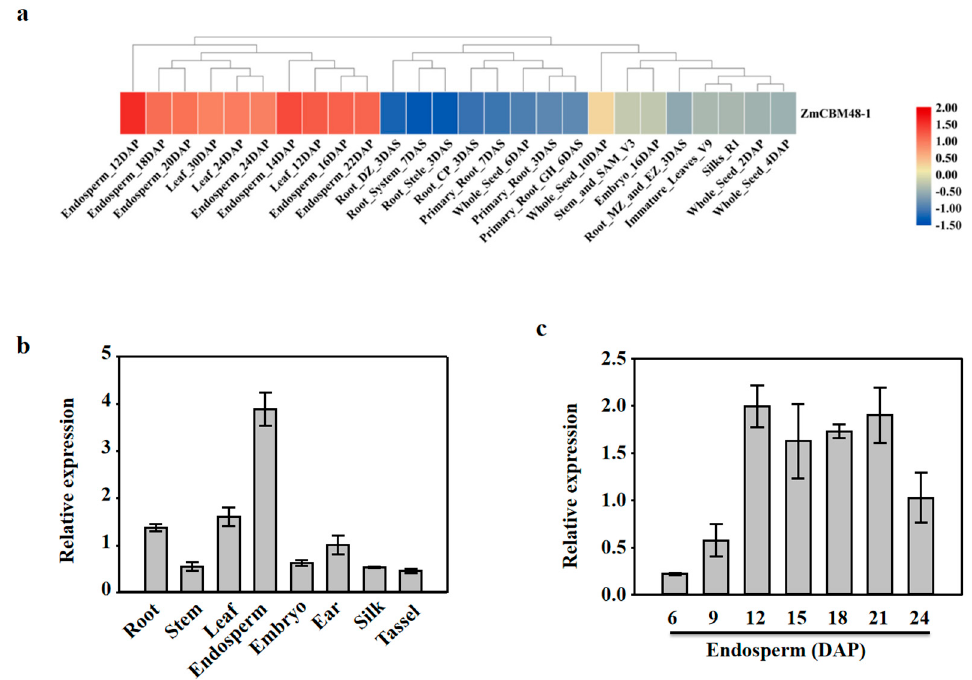
Figure 2. Expression profile analysis of the ZmCBM48-1 gene. ( a ) Expression profiles of ZmCBM48-1 in different tissues. Red, yellow, and white indicate high, medium, and low levels of gene expression, respectively. ( b , c ) Tissue-specific expression pattern analysis of ZmCBM48-1 in various maize tissues. The ZmActin1 gene was used as an internal control. Error bars are the standard deviations of three technical repeats and two biological repeats. DAP, days after pollination.